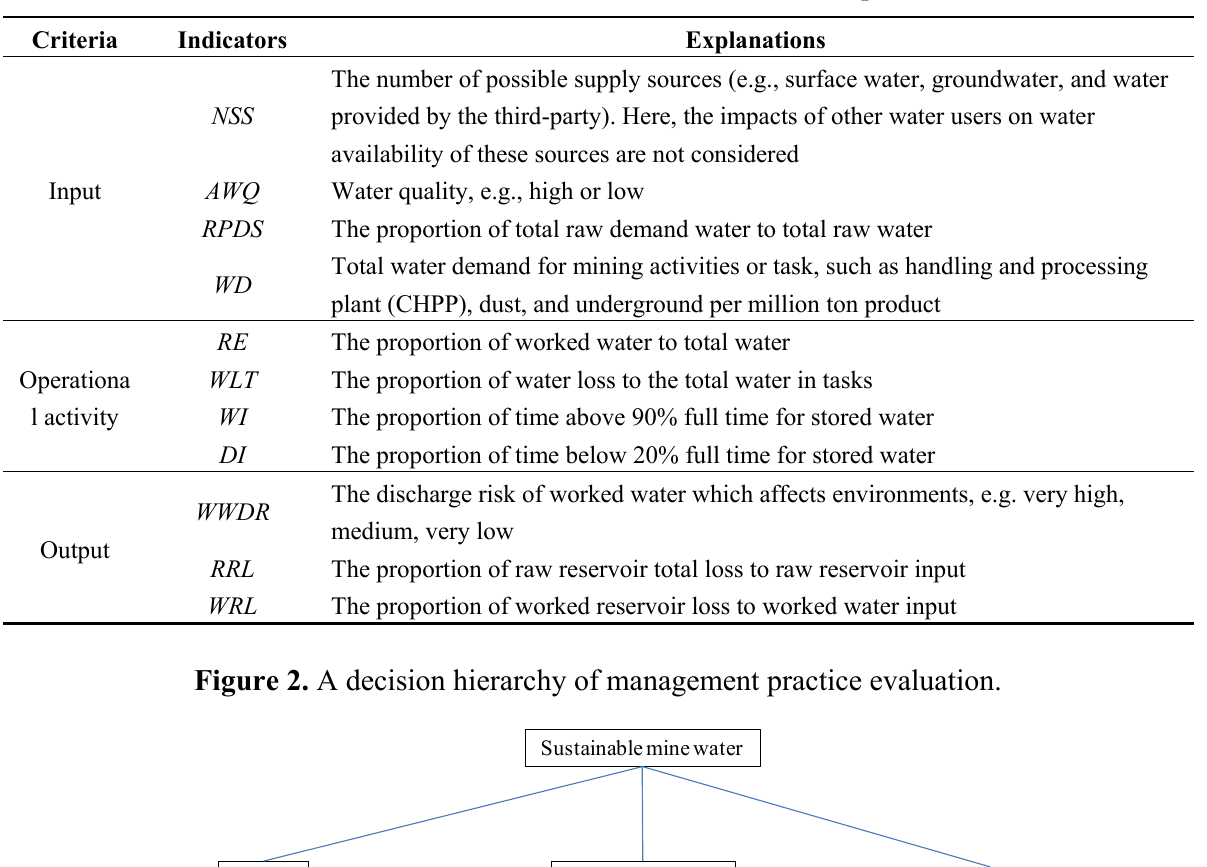
Table 2. The evaluation indicators and their descriptions.